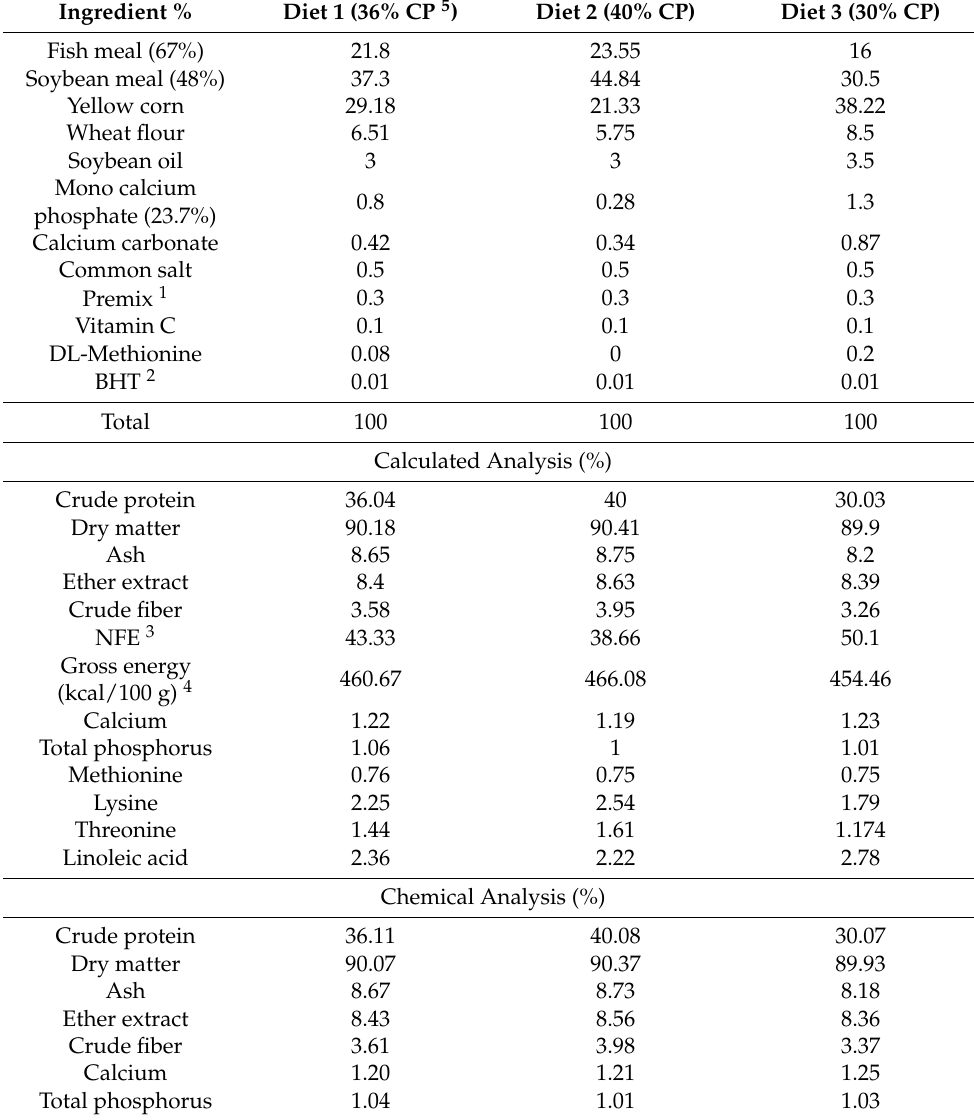
Table 1. Ingredients (%) and chemical composition of the experimental